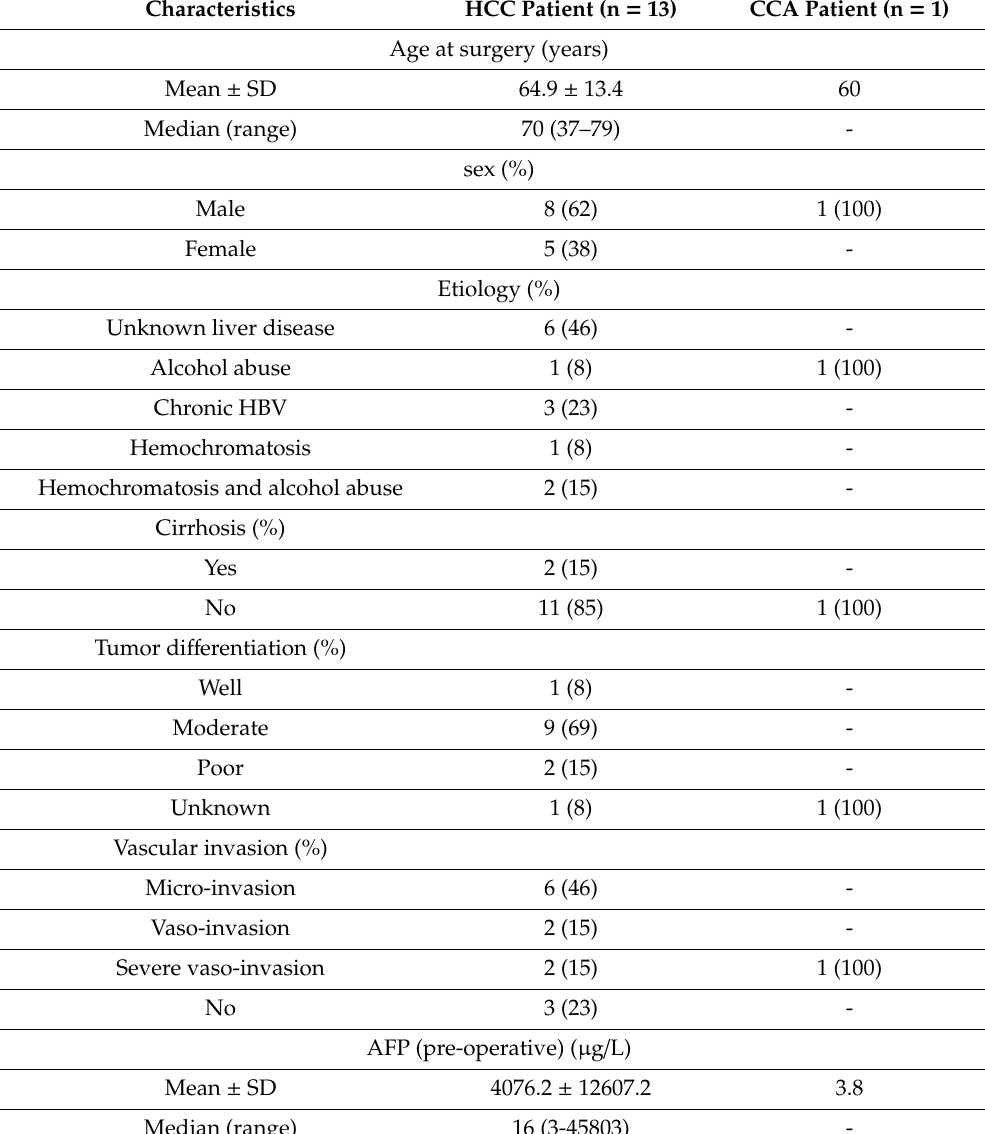
Table 1. Patient